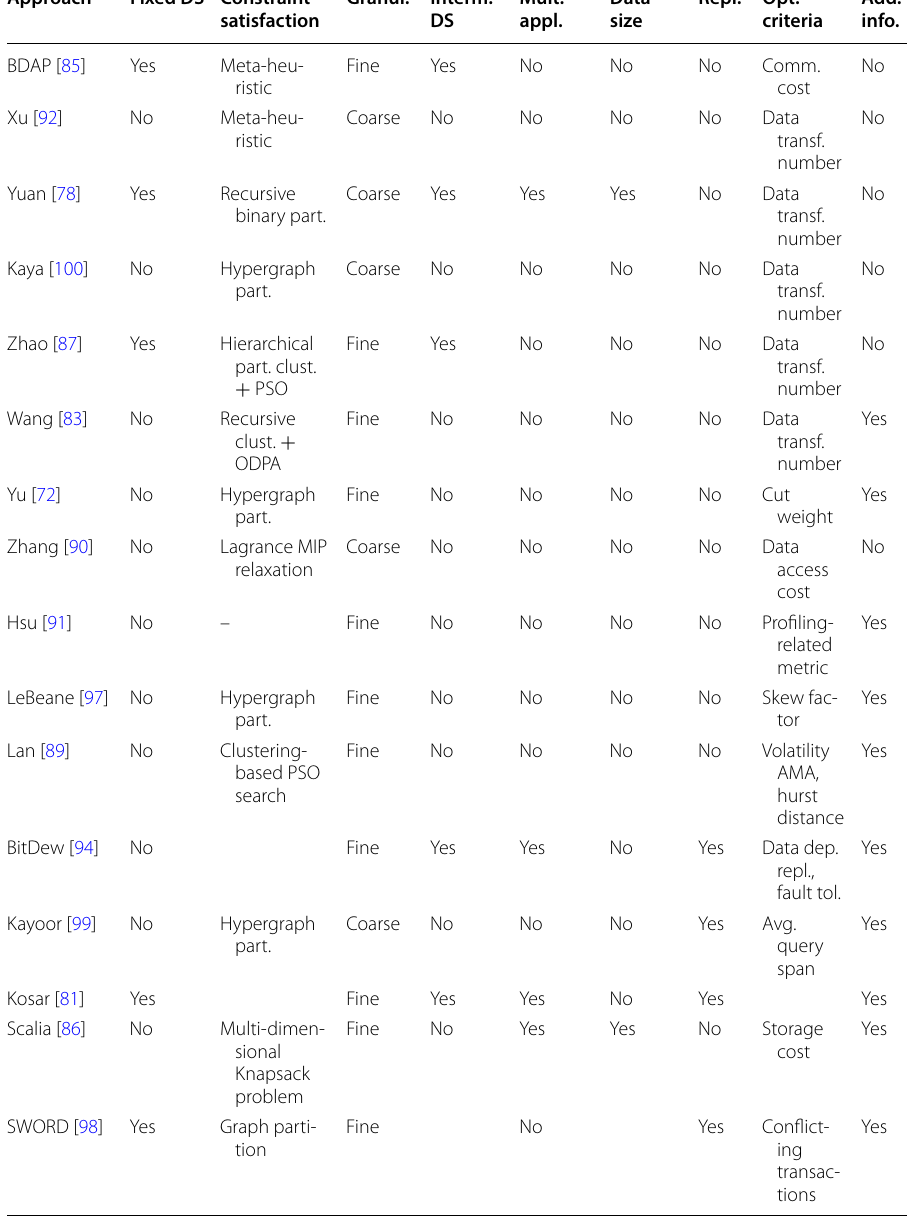
Table 4 Comparative summary of existing data placement algorithms Approach Fixed DS Constraint